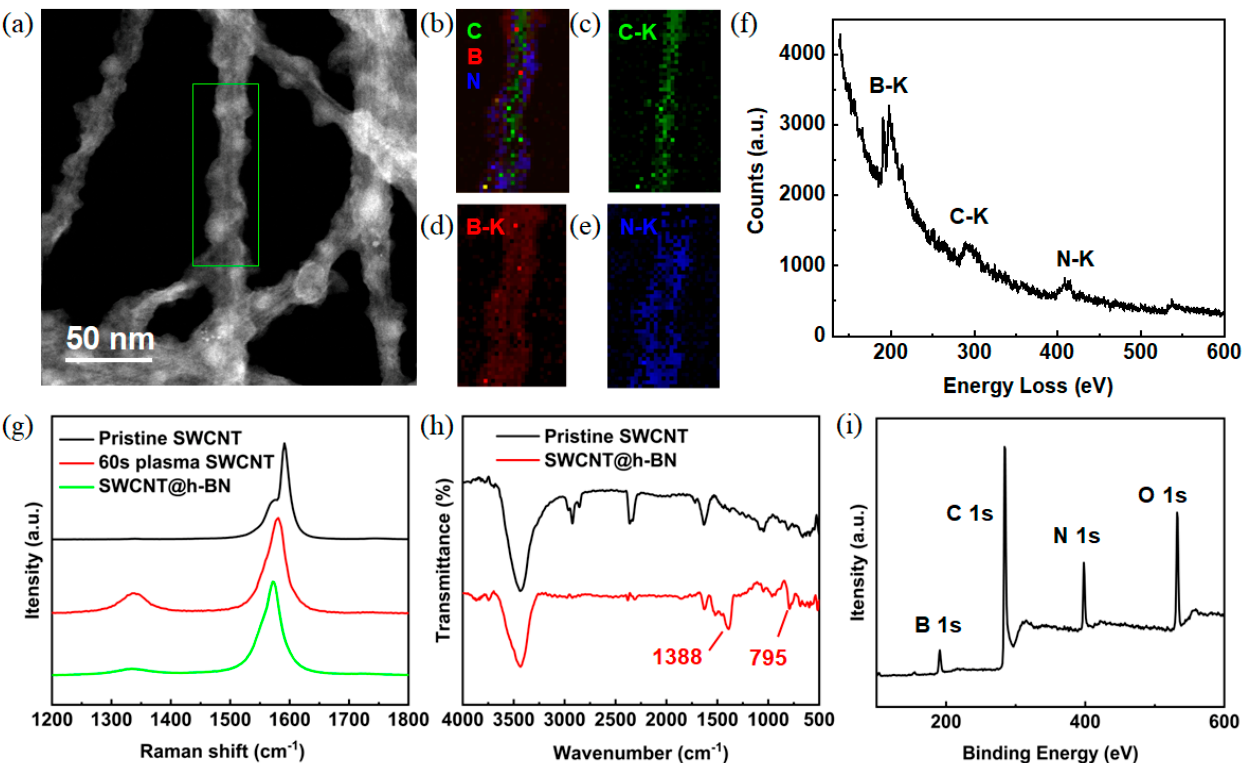
Figure 2. Structural characterization of SWCNT@h-BN. ( a ) ADF image, ( b - e ) EELS mapping, and ( f ) EELS spectrum of SWCNT@h-BN. ( g ) G and D bands Raman spectra of pristine SWCNTs, plasma- treated SWCNTs, and SWCNT@h-BN. ( h ) FT-IR spectra of original SWCNT and SWCNT@h-BN. ( i ) XPS spectrum of SWCNT@h-BN.